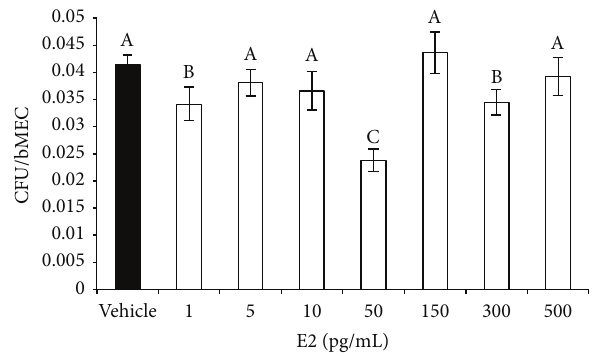
Figure 2: E2 decreases S. aureus internalization into bMECs. bMECs were treated with the concentrations indicated of E2 (24 h), and then were challenged with S. aureus during 2 h. Data are showed as the percentage of CFU recovered after bMEC lysis. Values were determined considering the control (bMECs cultured with the vehicle 1% ethanol) as 100% internalization. Each bar shows the mean of triplicates ± SE of three independent experiments. Different letters indicate significant changes among treatments ( 𝑃 < 0.05